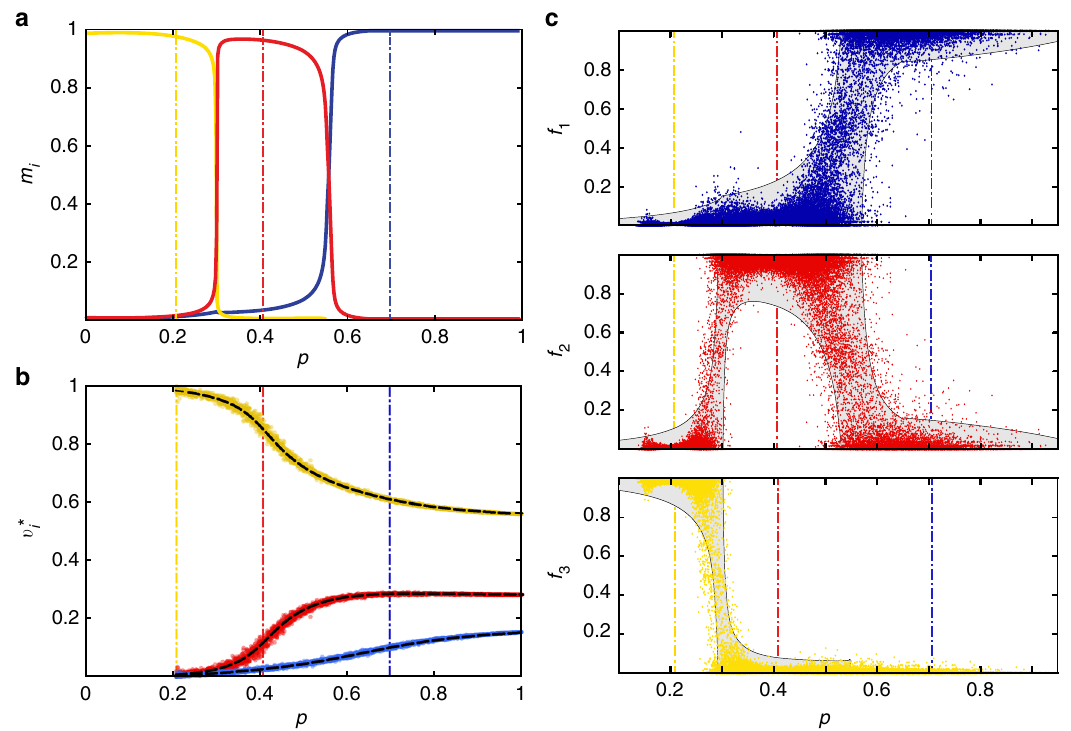
Fig. 5 Colour switching in fi nite components. a Theoretical expected fraction of colours m i as a function of percolation probability p features a switching behaviour in the example network with α = 0.1. These pro fi les are the same for all fi nite components independently of their size. b Theoretical and observed fraction of colours in the giant component. c The 2 σ spread of random variables f 1 , f 2 and f 3 as predicted in the components of size n = 50 is compared to observations in generated networks. The vertical guide lines mark values of p at which the disjoint network features phase transitions. A parametric study describing how colour fractions evolve in networks with various modularity is given in Supplementary Table